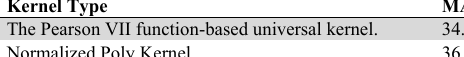
The kernel in gaussian processes Kernel Type MAE RMSE Kernel Type MAE RMSE The Pearson VII function-based universal kernel.